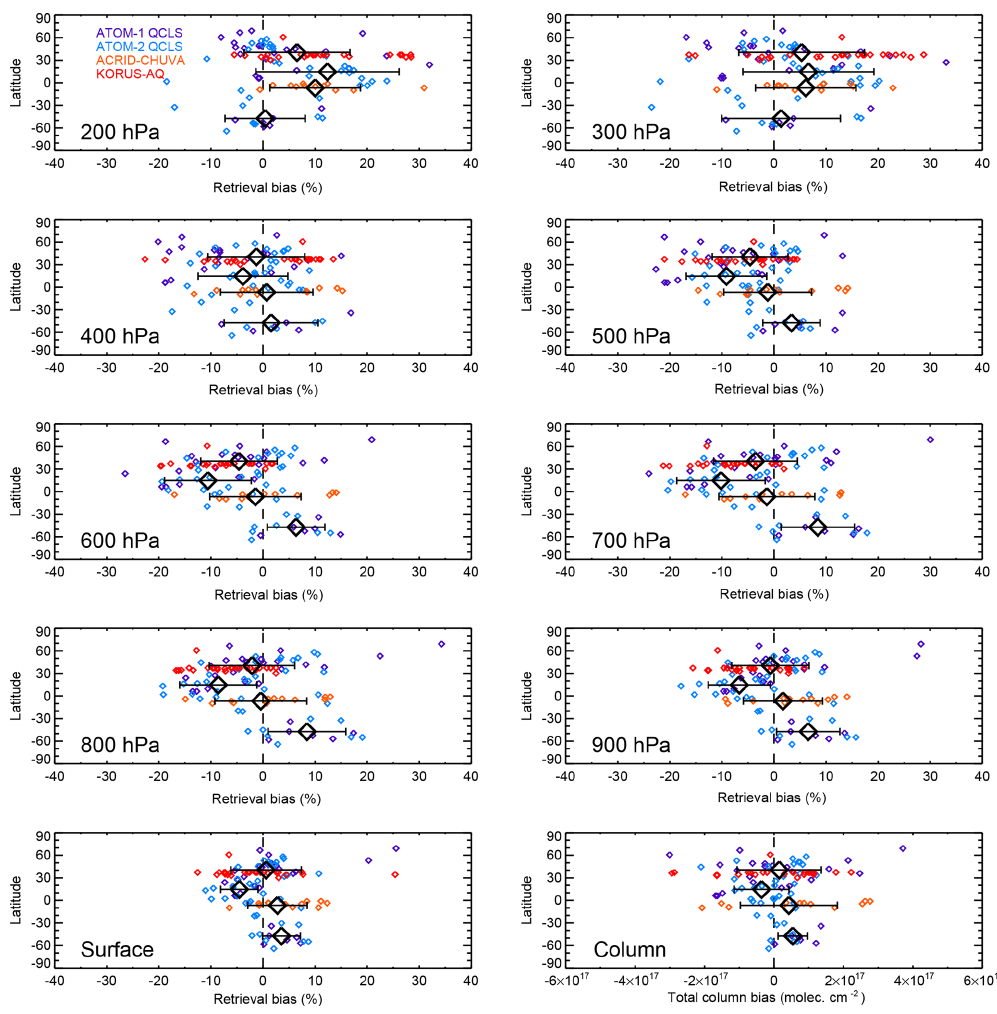
Figure 12. V8 TIR–NIR biases based on the ATom, ACRIDICON, and KORUS-AQ CO